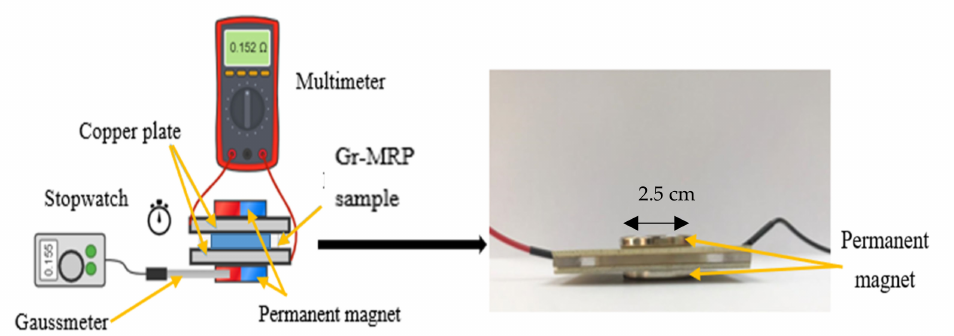
Figure 2. Experimental setup for measuring the resistance of the